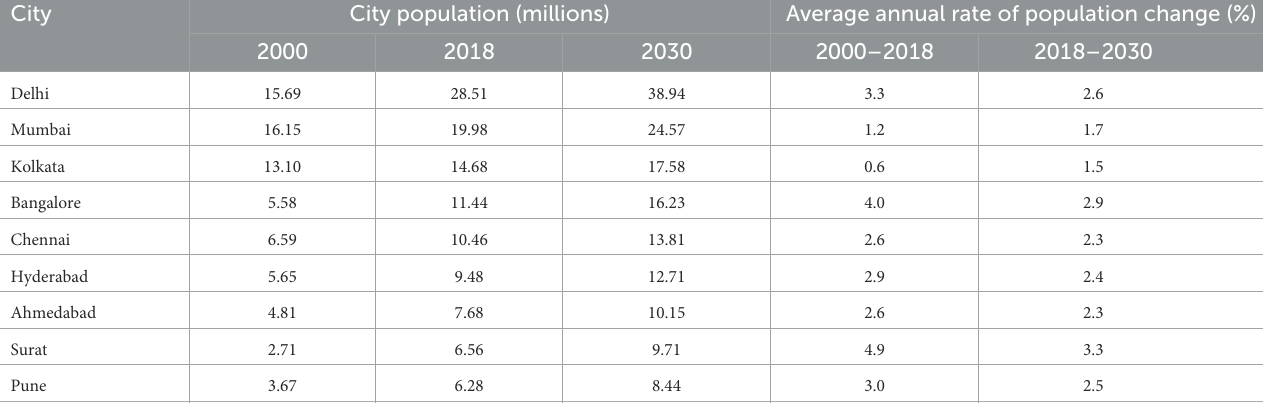
TABLE 1 Population statistics for the nine major populated Indian cities selected for the study. Past (2000), contemporary (2018), and future (2030) population (millions) are provided in the Table, along with the average annual rate of population change (%) from 2000 to 2018, and 2018 to 2030 [Source: United Nations (UN),